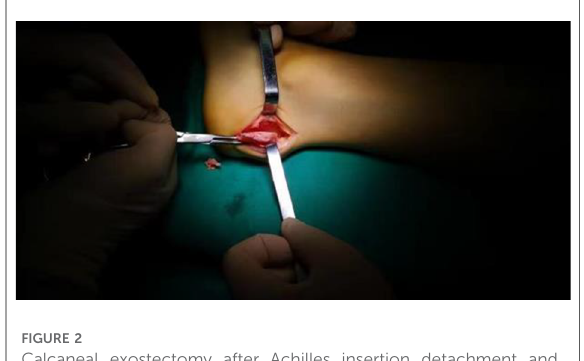
FIGURE 2 Calcaneal exostectomy after Achilles insertion detachment and debridement.